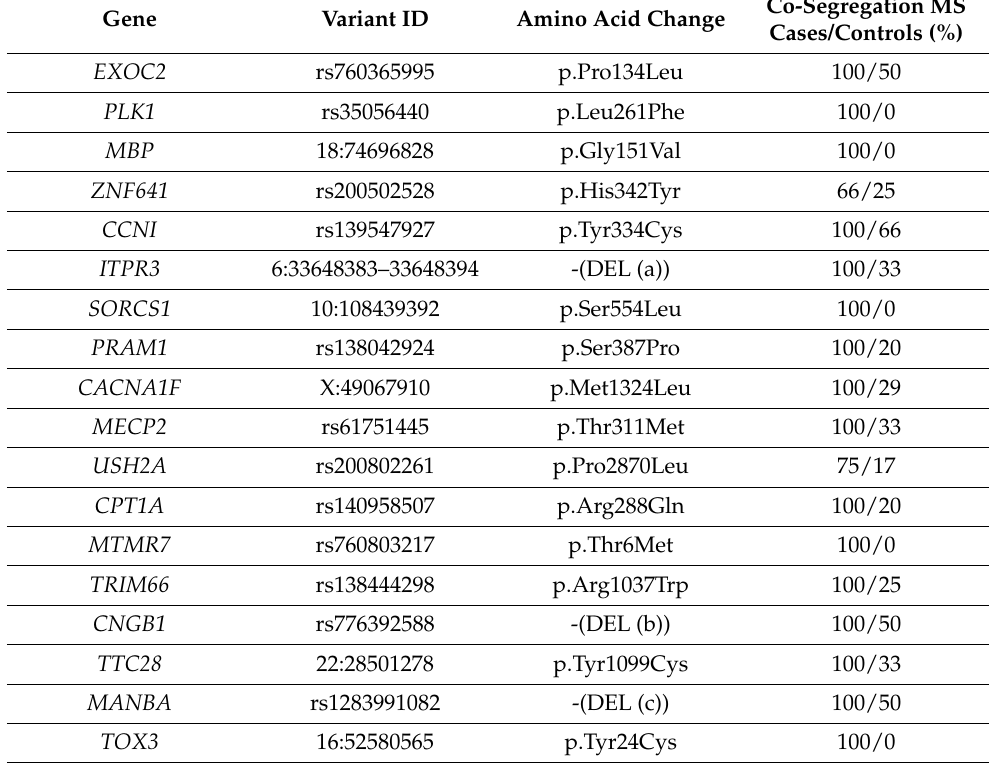
is indicated as the variant being present in all MS cases and absent in all controls within one or two families, while acceptable co-segregation implies that the variant is present in all MS cases and is present in a maximum of 33% of controls. In total, 12 rare genetic variants show complete or acceptable